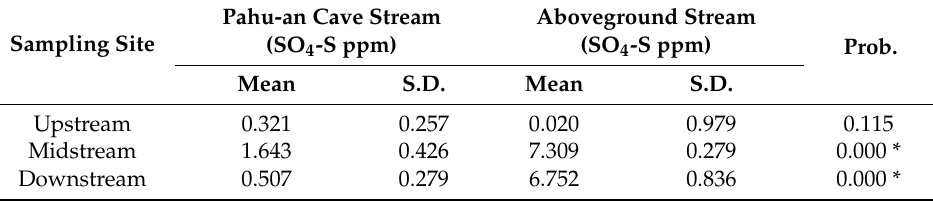
Table 6. Sulfate content (water).